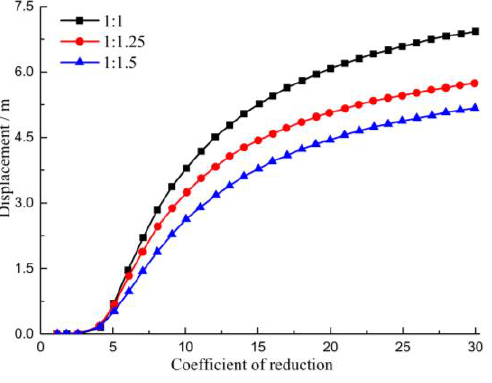
Figure 17. Displacement curves at the top of the slope with different excavation slope ratios.